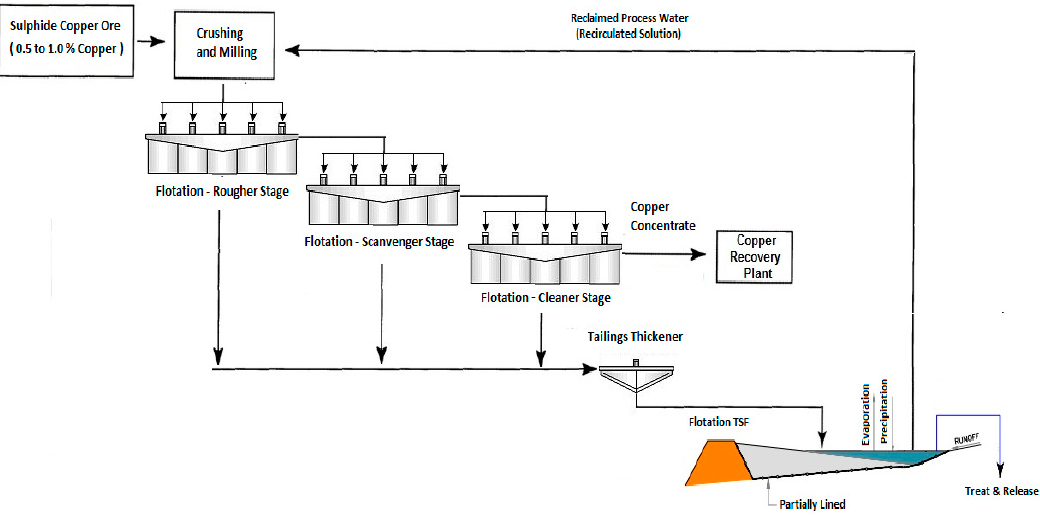
Figure 2. Typical Copper Ore Sulphide Process.